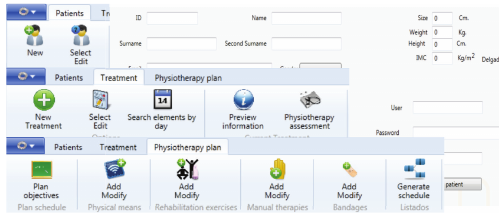
Figure 5: Physiotherapist options menu of the